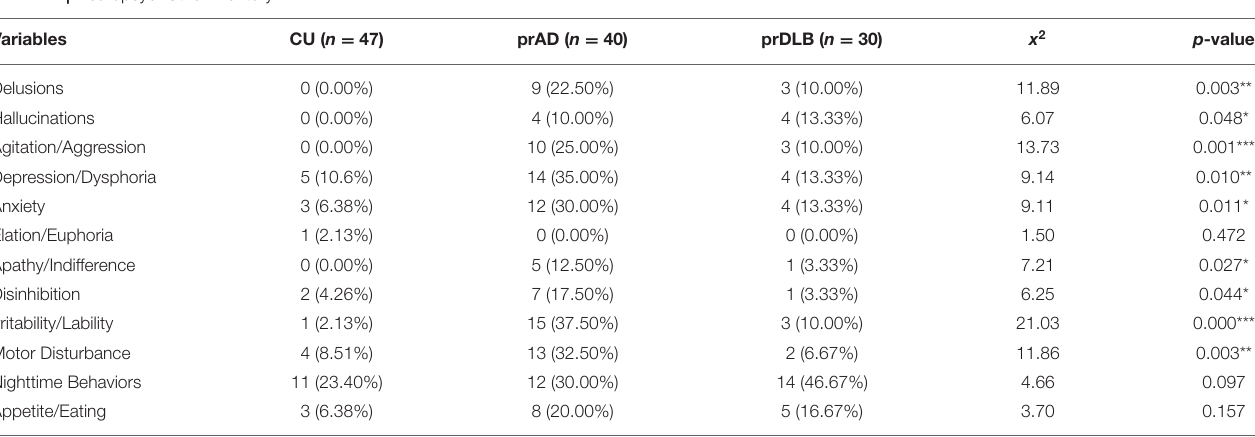
TABLE 2 | Neuropsychiatric